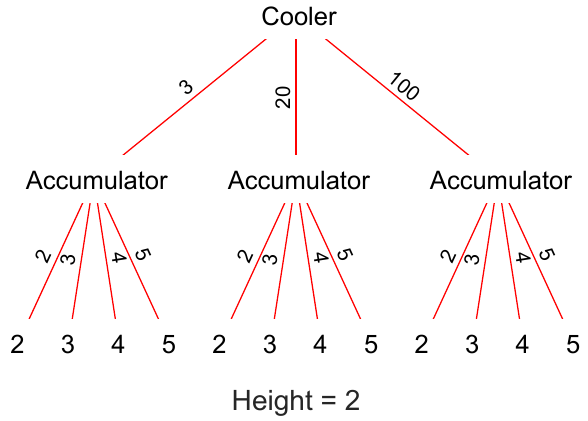
Figure 15. Graph of a hierarchical model which achieves better ac- curacy when predicting the hydraulic accumulator fault by training specialized models for different cooling